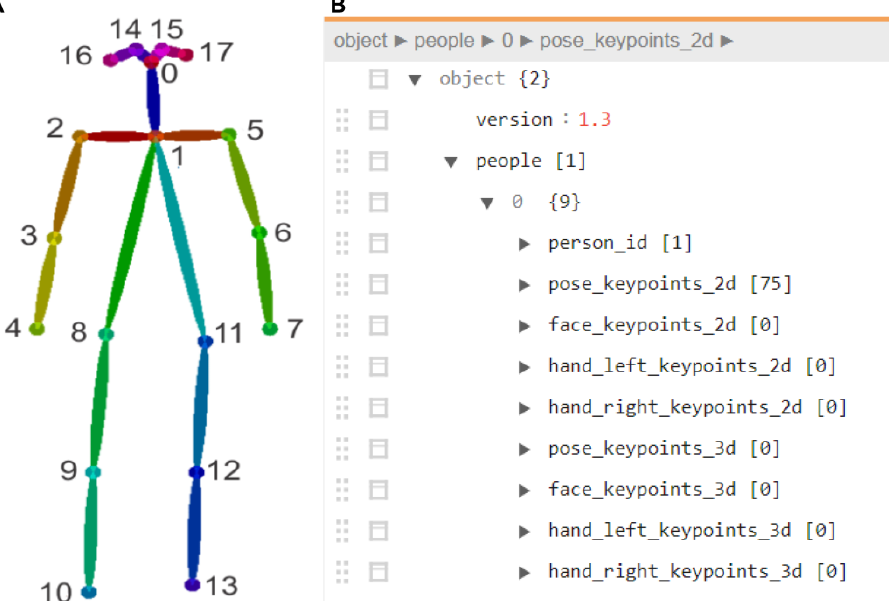
Figure 15. ( A ) Schematic diagram of the key points analyzed by the AI. ( B ) Posture key point data. Schematic diagram of the key points analyzed and the posture key point data by the AI.